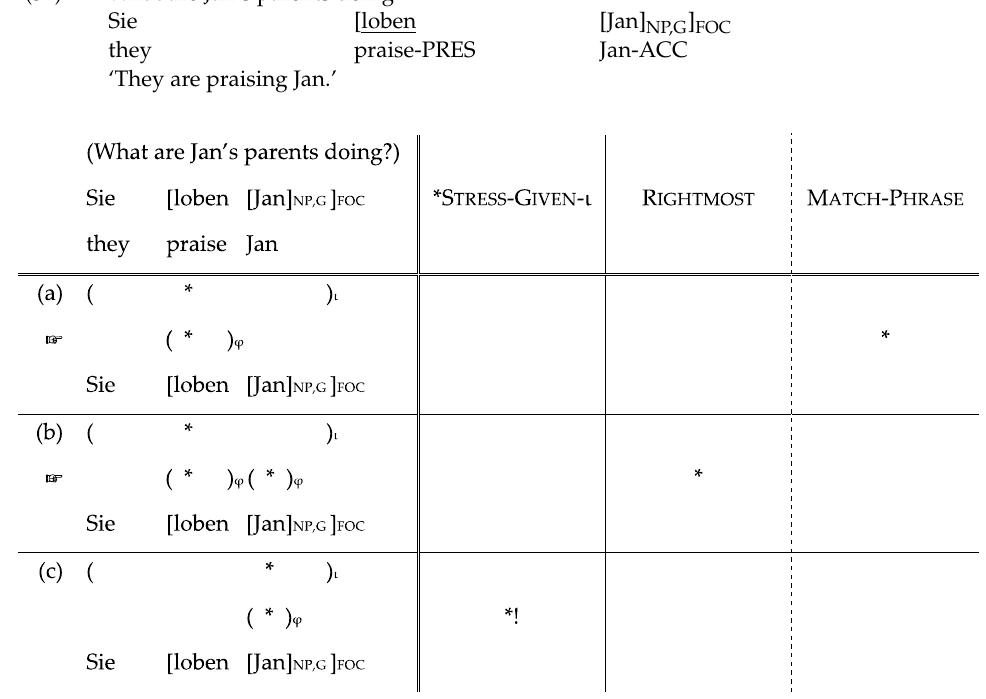
Figure 4. Prosodic structures predicted by *S TRESS -G IVEN - ι >> R IGHTMOST , M ATCH -P HRASE for an SVO sentence with a discourse-new verb and a discourse-given object under focus.